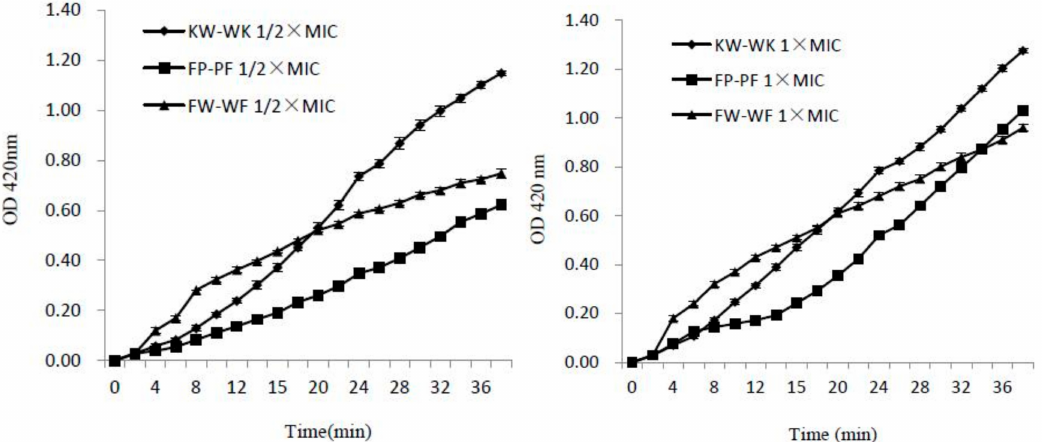
Figure 6. Release of cytoplasmic β -galactosidase in E. coli UB1005 cells treated with antimicrobial peptides at concentrations of 1/2 × MIC and 1 ×